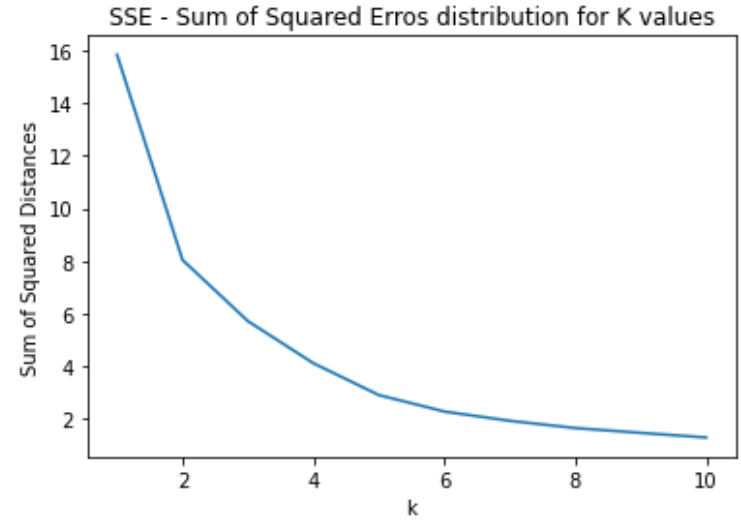
Figure 15. SSE variation according to K values in Marvila.